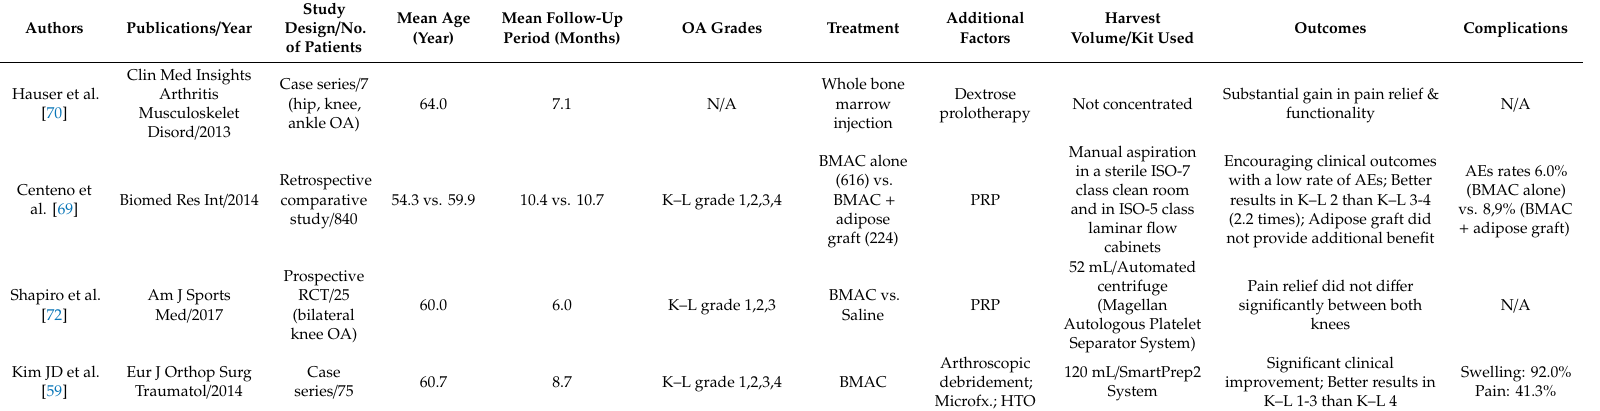
Table 3. Details of the clinical trials of BMAC focusing on